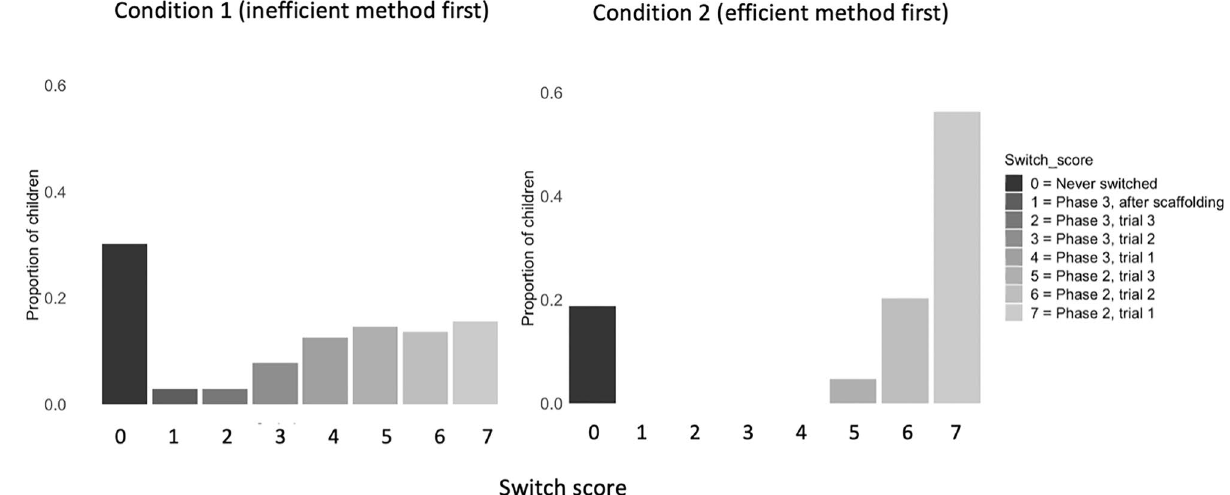
Figure 1. The proportion of children who switched at the different points in the experiment, by